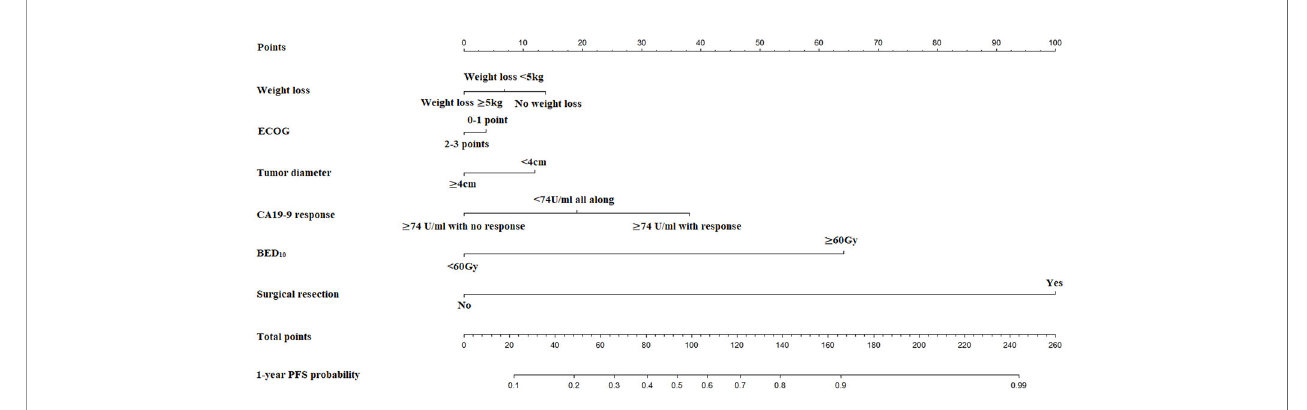
FIGURE 3 | The nomogram for predicting probability of PFS at 1 year.